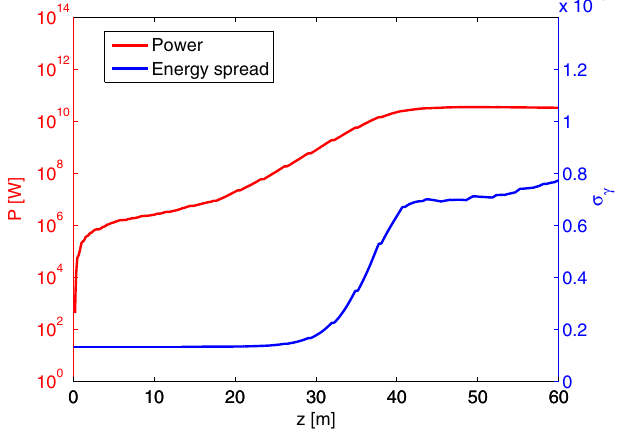
FIG. 10. The gain cure in logarithmic coordinate (red line) and the slice energy spread (blue line) of the main current peak in different distances along the undulator.